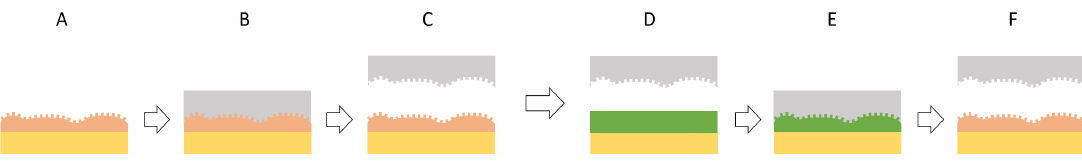
Figure 5. Optical micrograph of the grating on top of the diffusor structure. The lines and spaces follow the topography of the surface. Figure 6. AFM images of the hierarchical structures master used for further imprinting. The left and right images have line and space dimensions of 300 nm/900 nm and 400 nm/1200 nm, respectively.